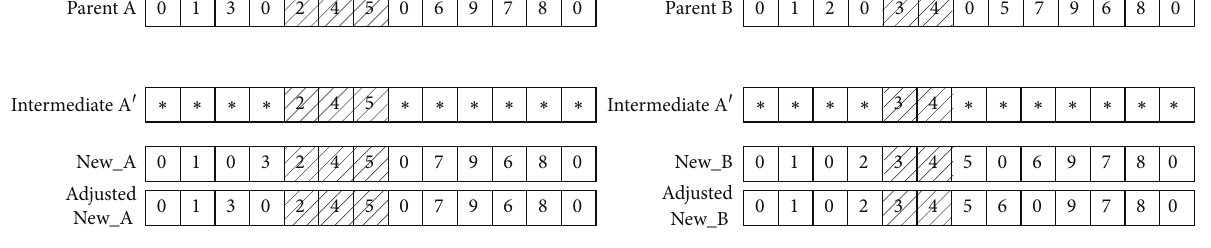
Figure 2: The crossover operator.